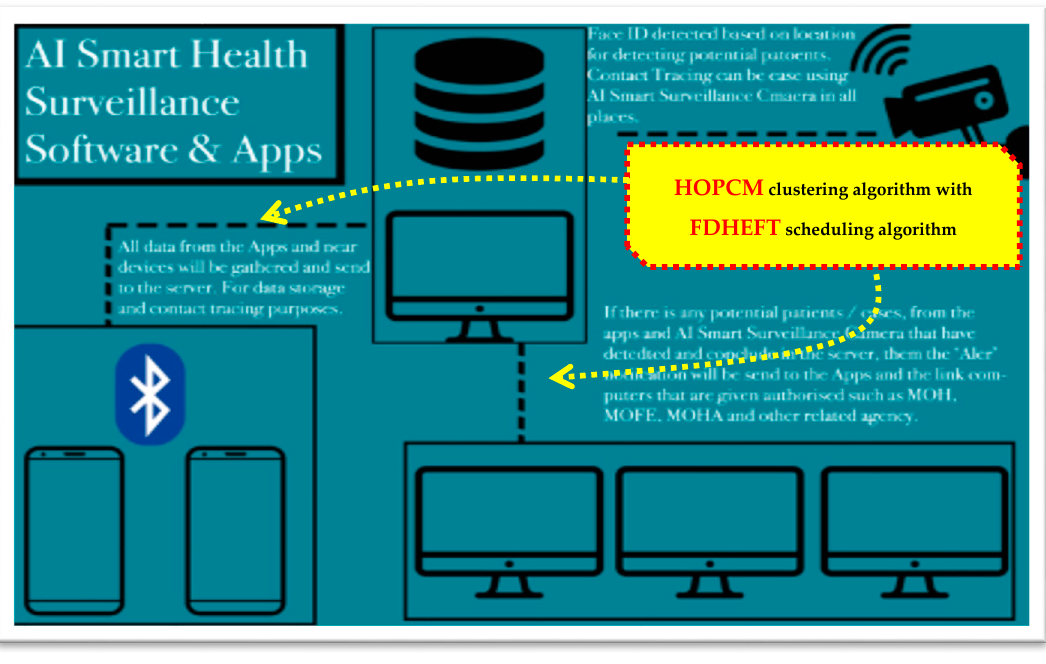
Figure 6. Architecture of cloud based smart health.